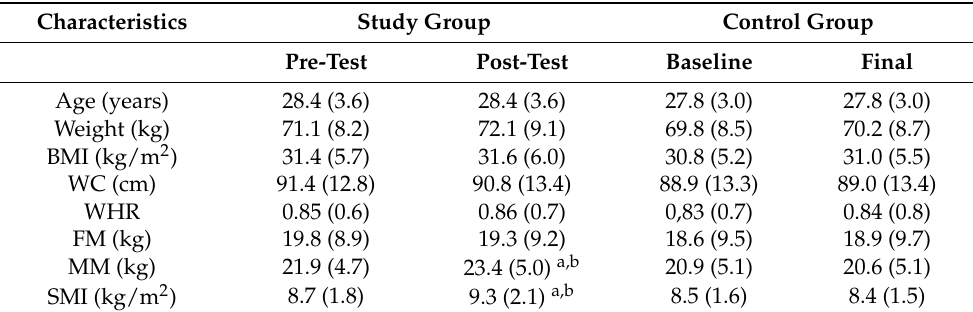
Table 2. Influence of the circuit resistance training programme on body composition in adults with Down syndrome at baseline and after completing the intervention programme. Characteristics Study Group Control Group Pre-Test Post-Test Baseline